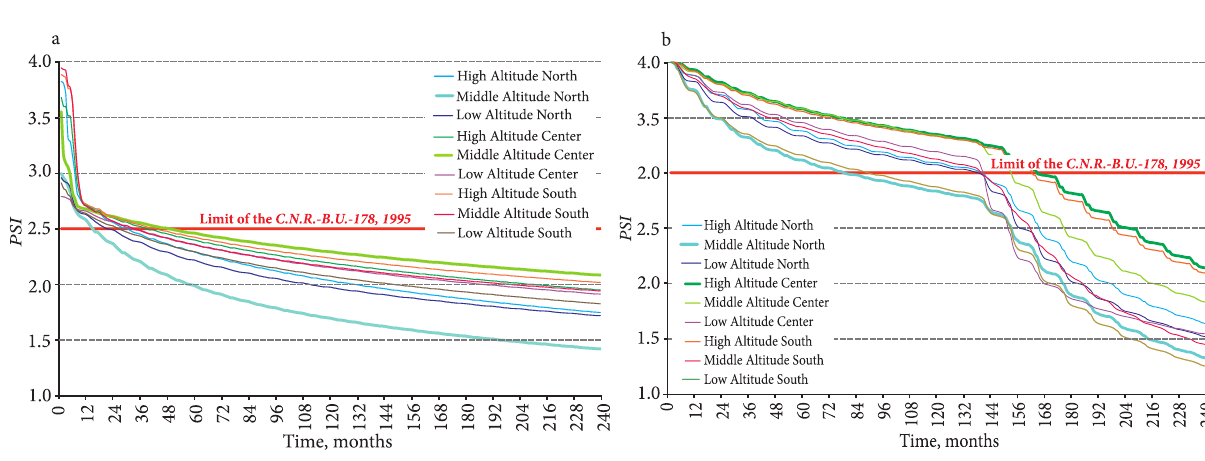
fig. 9. Simulation PSI decay: a – highway rigid pavement; b – freeway rigid pavement